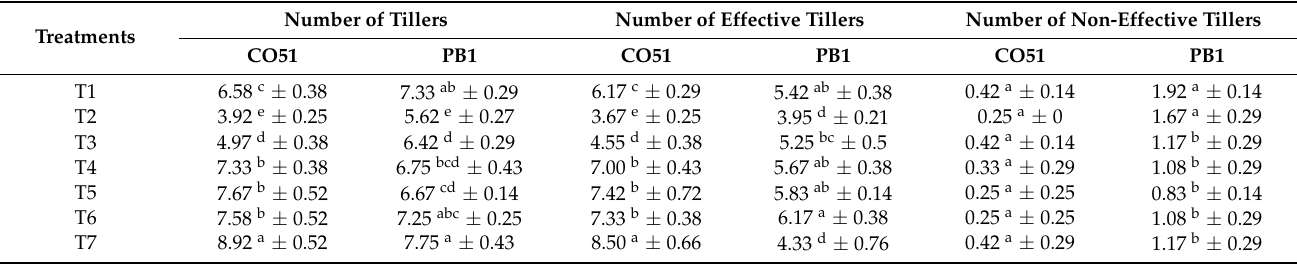
Table 2. Effect of inoculation of halotolerant endophytes and rhizobacteria on growth parameters of two rice varieties, CO51 and PB1.